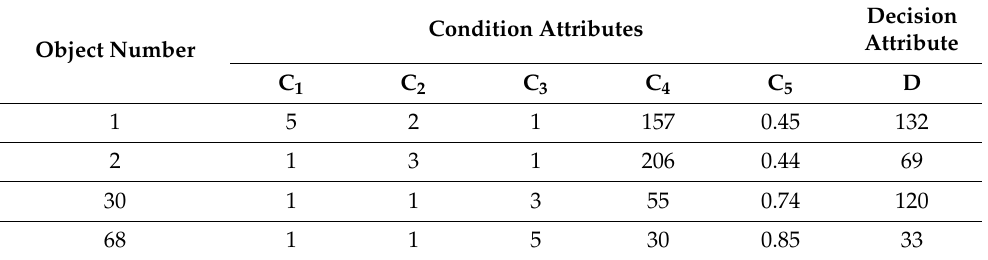
Table 3. Information system (decision table).